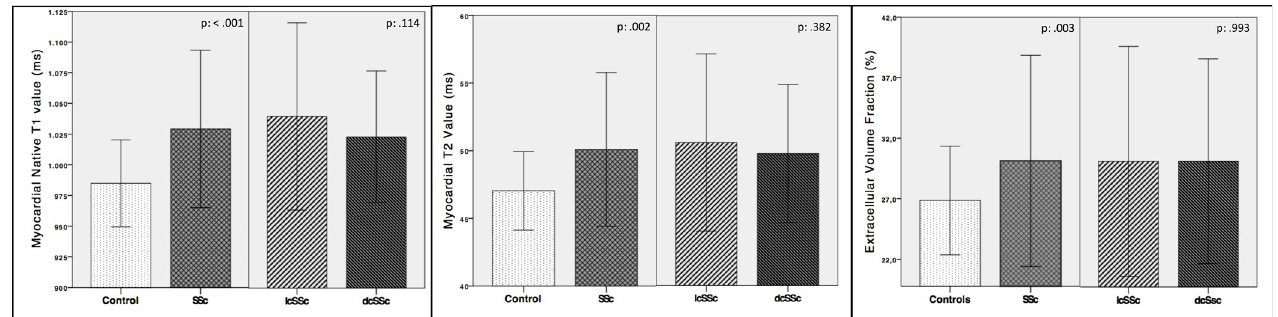
Fig 3. Box plot graphs of native T1, T2 and ECV. Mean values, +/- 1 Standard Deviation bars; SSc = systemic sclerosis; lcSSc = limited cutaneous form; dcSSc = diffuse cutaneous form.